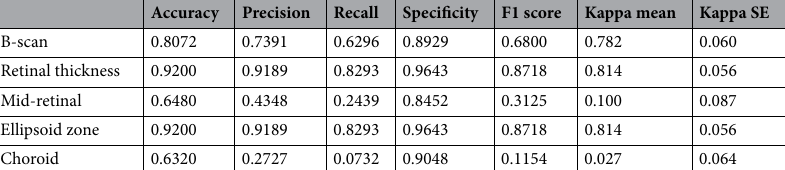
Table 2. The performance of the deep learning models trained using each OCT image set for CSC prognosis. OCT: optical coherence tomography; CSC: central serous chorioretinopathy; SE: standard error. F1 score = 2 × {(precision × recall)/(precision + recall)}.